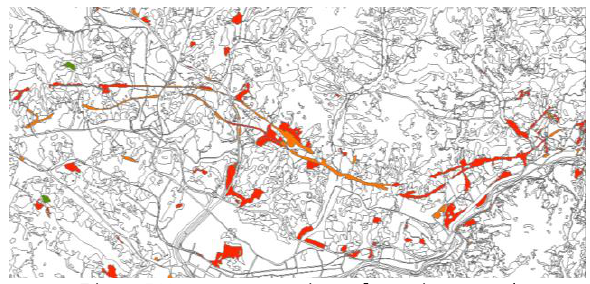
Figure 5 Water conservation polygon